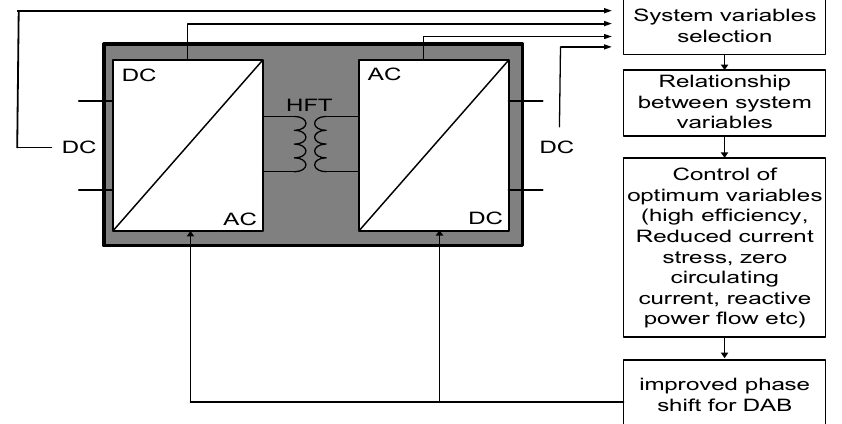
Figure 7. Detailed representation of DAB converter control techniques. Table 4. Phase-shift modulation strategies [58].